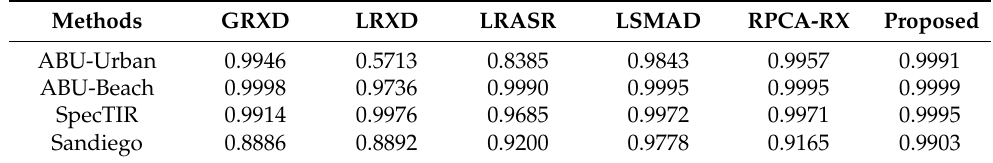
Table 2. The contrast in AUC from six anomaly detection methods. Methods